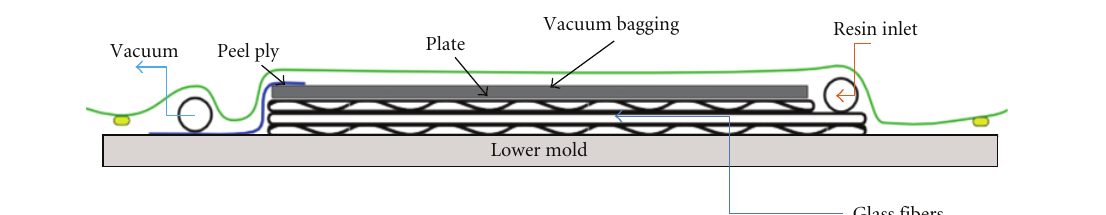
Figure 1: Nanoclay dispersion methods.